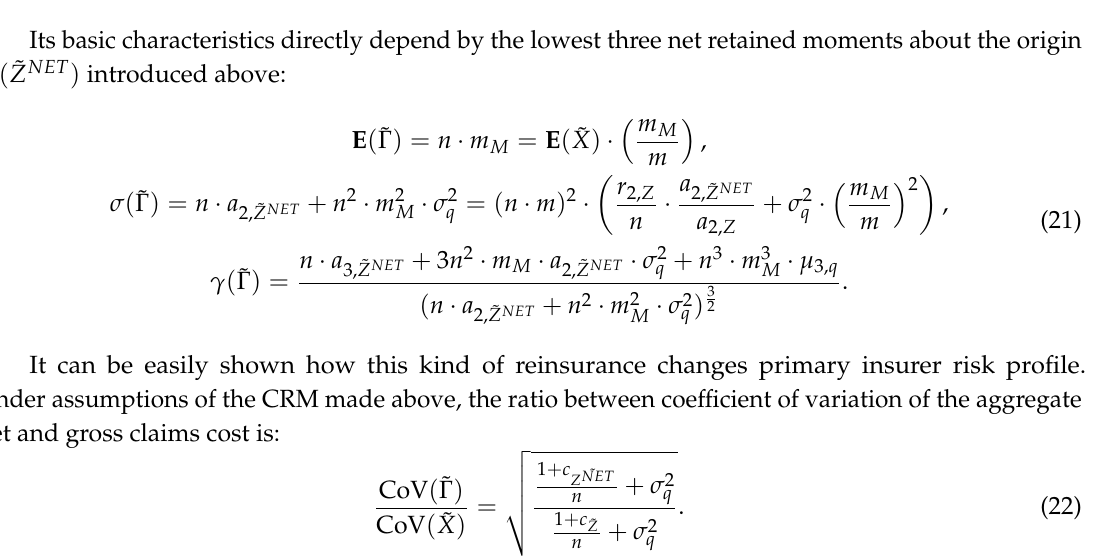
and retention limit (by multiplicative Z